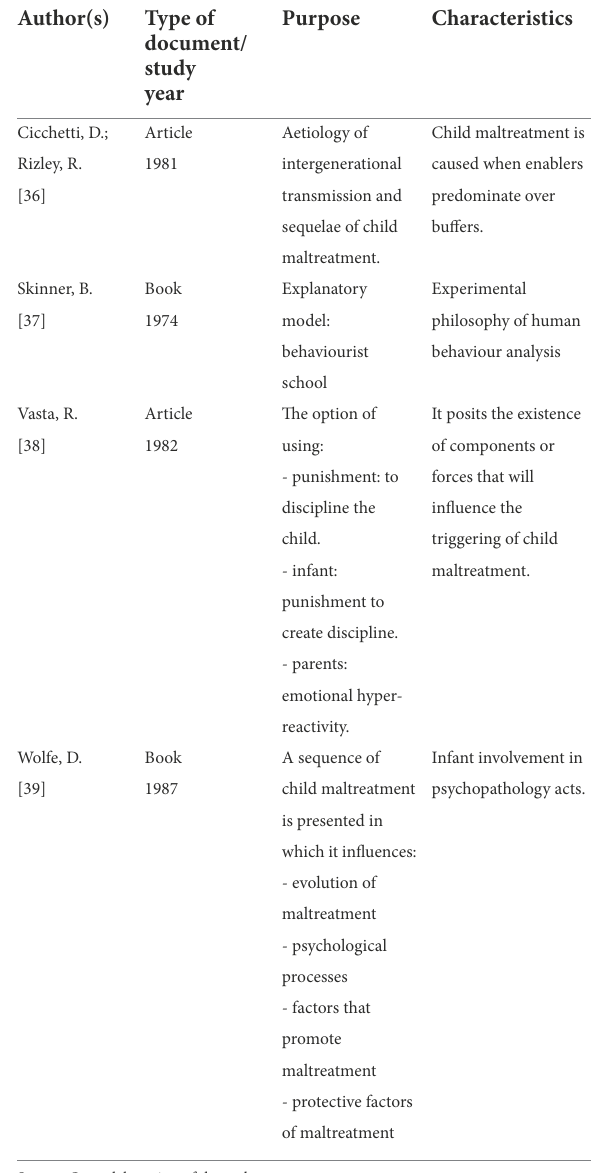
TABLE 2 Dcumentation included within the scope of child maltreatment.